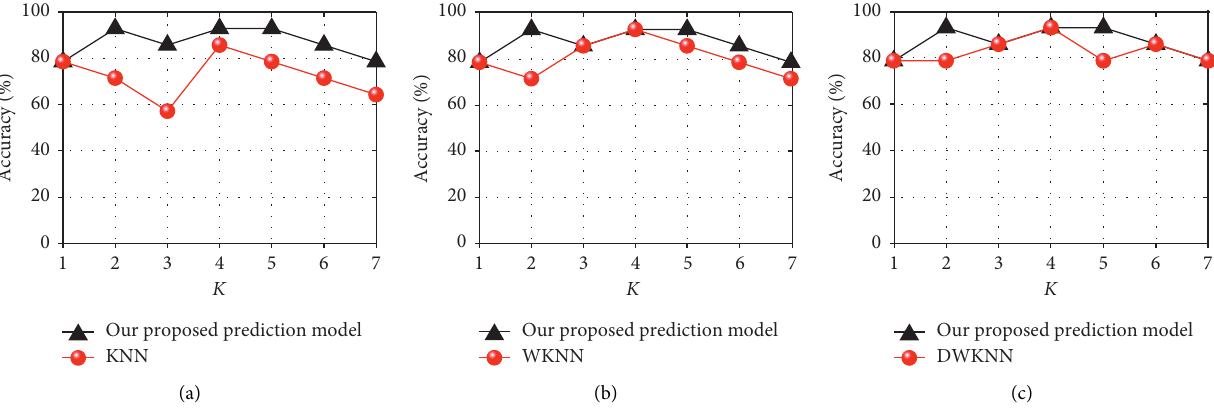
Figure 2: Prediction results between our proposed approach with other approaches. (a) KNN algorithm. (b) WKNN algorithm. (c) DWKNN algorithm.